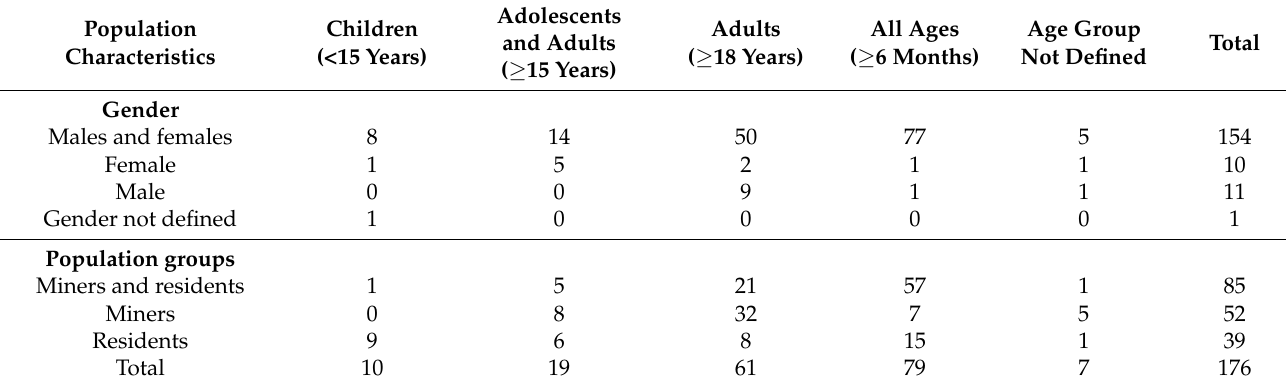
Table 1. Distribution of study populations by age group, gender, and population groups ( n = 176). Population